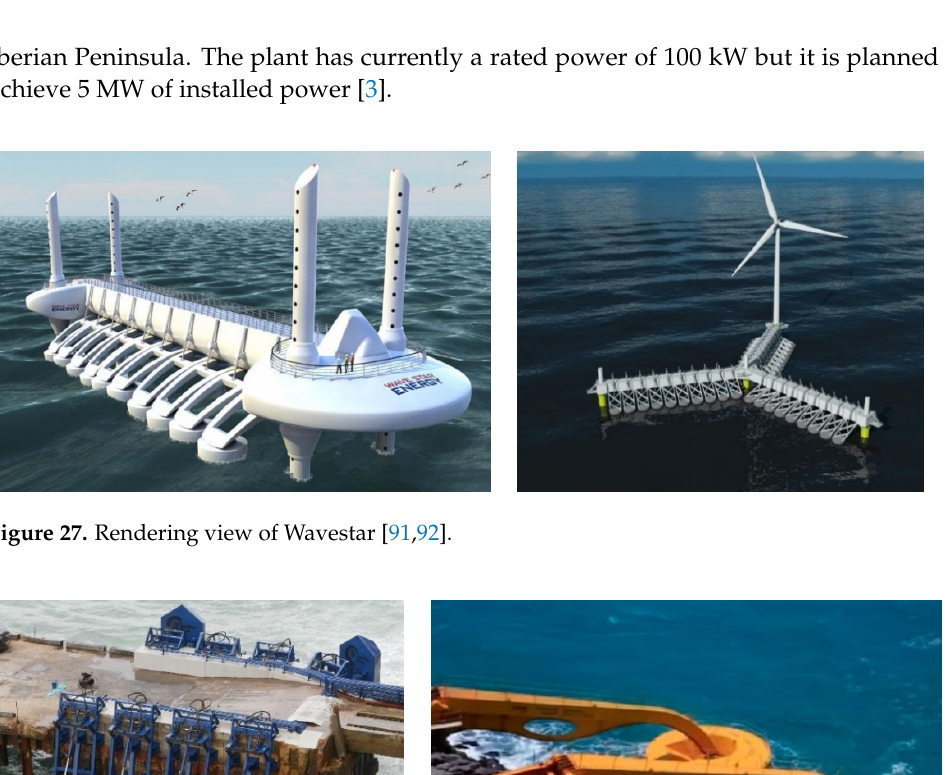
Figure 28. View of Eco Wave Systems installed on Gibratal ( left ) [93] and Seahorse power take-off system ( right ) [94].